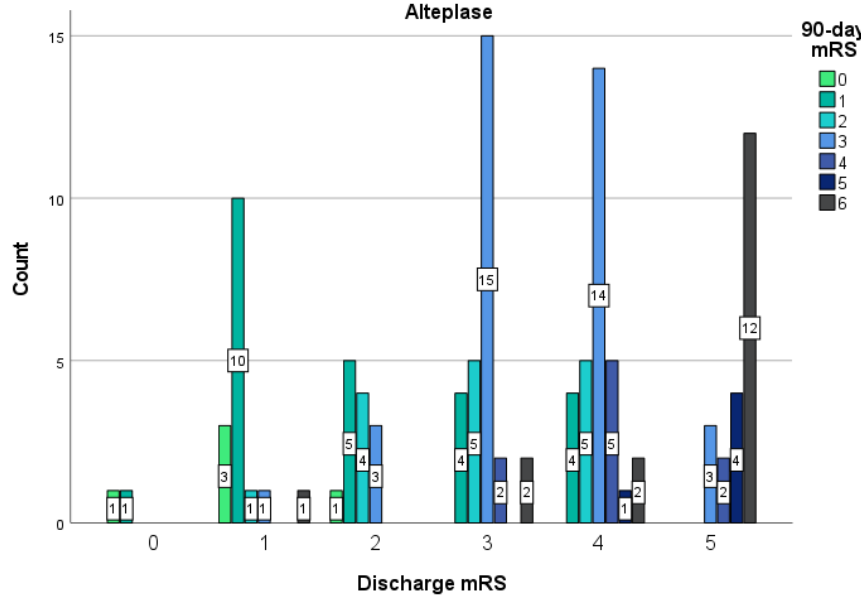
Figure 2. Distribution of the discharge mRS and the 90-day mRS between patients treated with Alteplase. Shown is the distribution of scores for disability on the modified Rankin Scale (which ranges from 0 to 6, with higher scores indicating more severe disability, and 6 indicating death) among patients in the Alteplase group during discharge and after 90 days. The bars indicate the mRS results after 90-days. The numbers in the bars are the count of patients who had each score after 90-days.